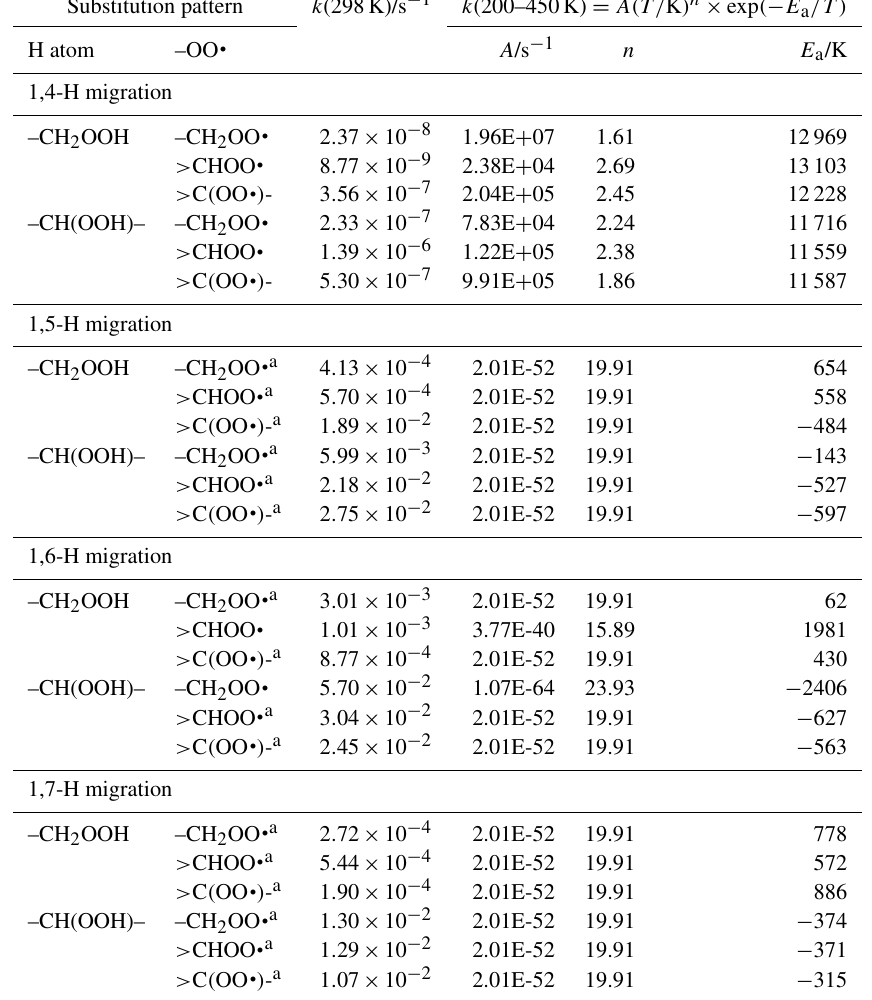
Table 7. Rate coefficients for H migration of α -OOH H atoms in peroxy radicals, accounting for all abstractable H atoms in the group. Substitution